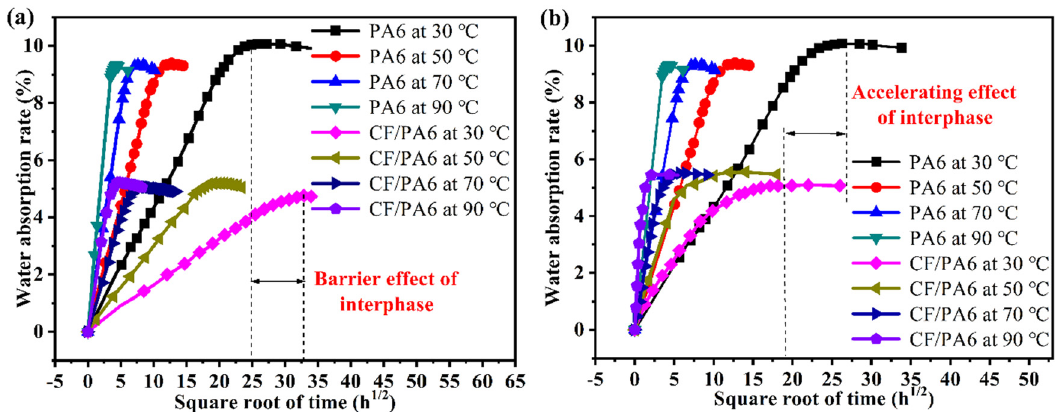
Figure 6: Water absorption curves of ( a ) PA6 resin and CF/PA6 ( Panex ® 35 - 50K ) composites and ( b ) PA6 resin and CF/PA6 ( SYT49S - 12K ) composites at 30, 50, 70, and 90°C.